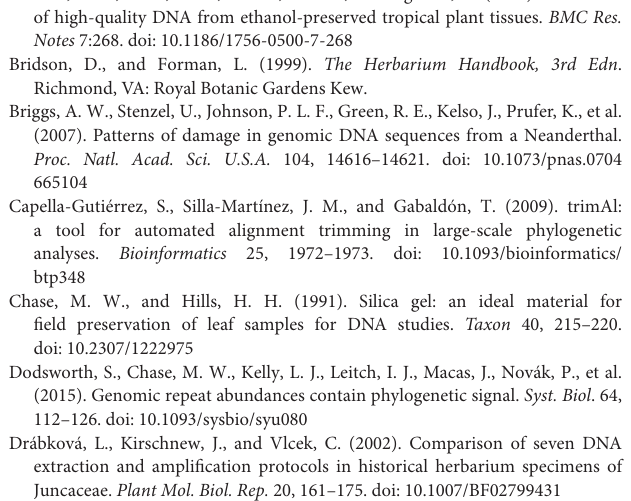
Supplementary Table 1 | Begonia bait set. Sequence identity, annotation, sequence divergence from orthologs of loci chosen as baits. Supplementary Figure 1 | Distribution of true and erroneous GA and CT SNPs. The scales on the y-axes vary between charts. (A) The proportion of true and erroneous SNPS for the dinucleotide GA by species and treatment. (B) The proportion of true and erroneous SNPS for the dinucleotide CT by species and